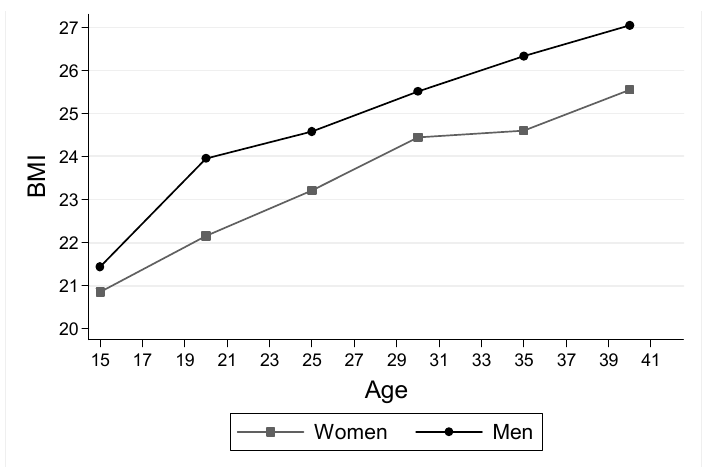
Figure 1 : BMI RE growth curve by age and gender (with age